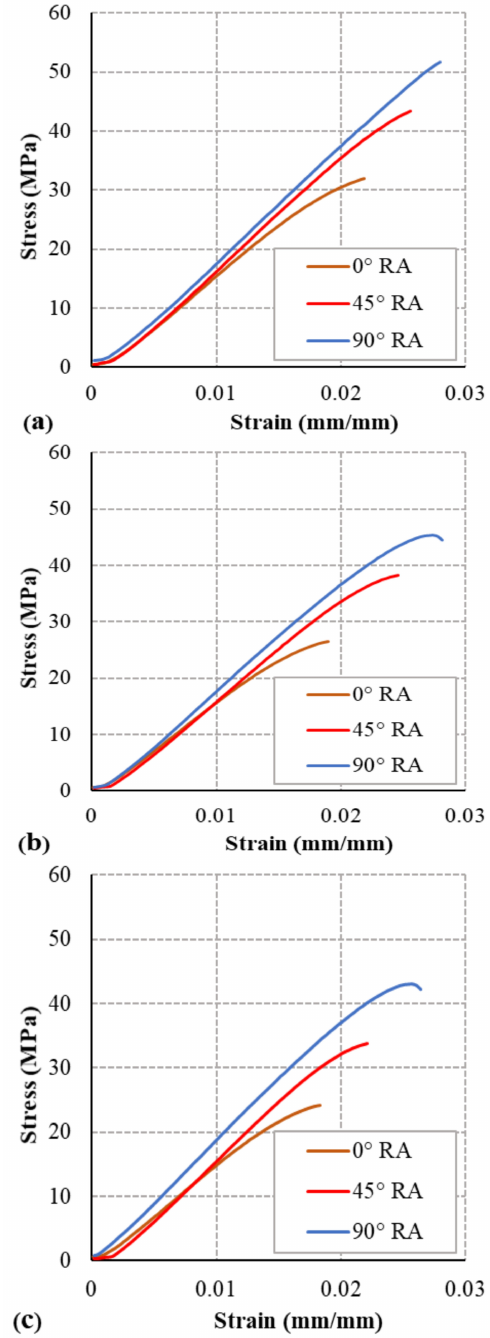
Figure 6. Tensile stress–strain curves for ( a ) 10% MC, ( b ) 5% MC, and ( c ) 1%